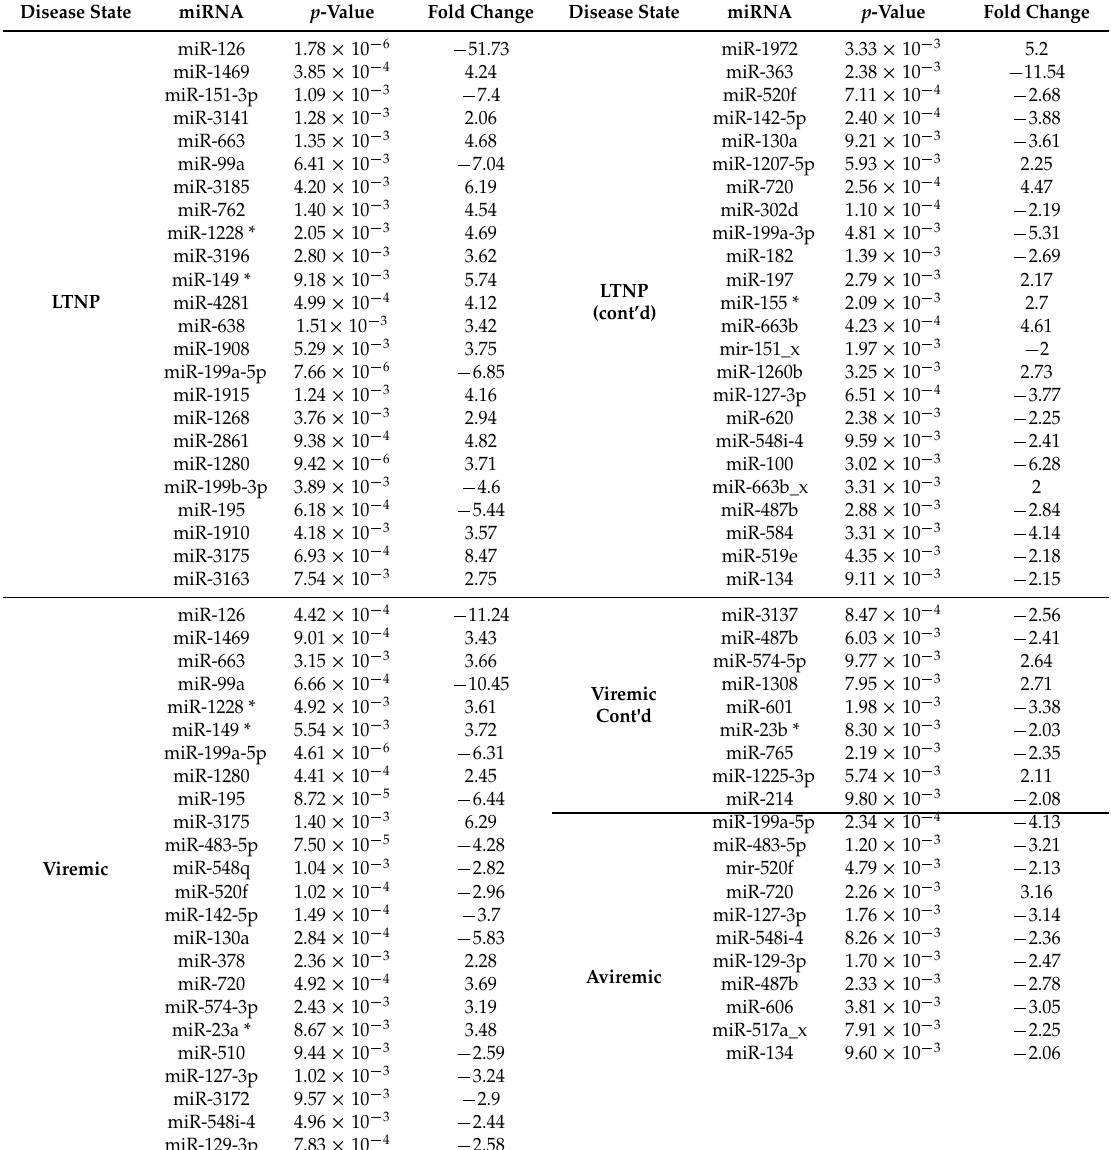
Table A2. Differentially expressed miRNAs of CD4+ T-cells in each disease state when compared to negative